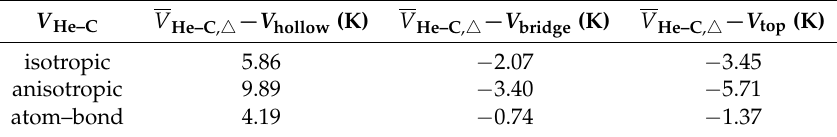
Table 5. The difference between V He–C ( z e ) and its lateral average V He–C, (cid:52) ( z e )